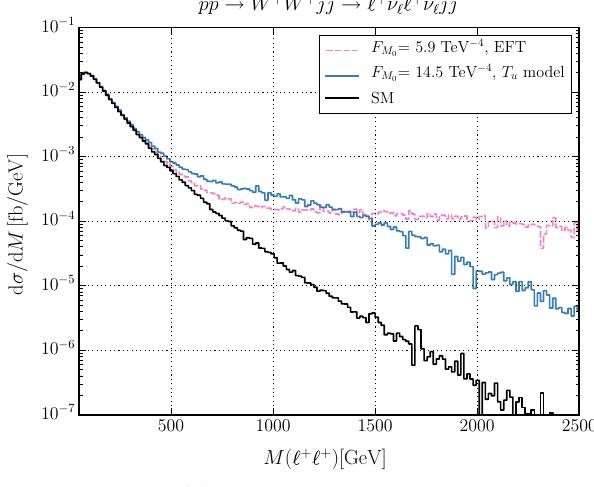
The solid blue line shows the a unitarized curve with the same fiducial cross section as the EFT curve using the T u model. The fiducial region is defined in Eq. (34)